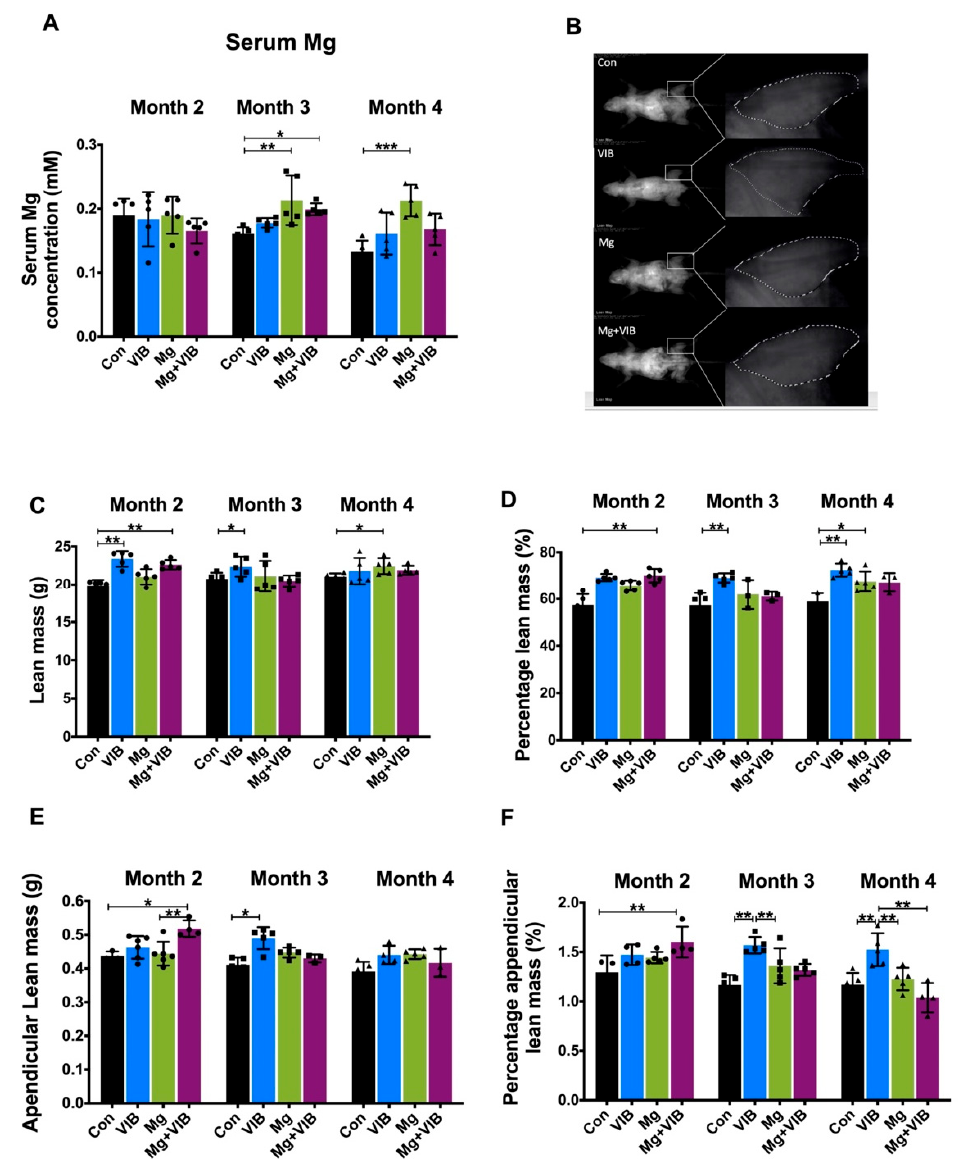
Figure 1. Body mass parameters by Dual Energy X-rat Absorptiometry (DXA) and serum Mg concentration of SAMP8 mice. ( A ) Serum Mg levels in Con group showed a decreasing trend from month 2 to month 4, and serum Mg concentration in the Mg group was significantly higher than in the Con group at month 4. ( B ) Representative DXA images in lean mass mode. ( C ) Lean mass, ( D ) lean mass percentage, ( E ) appendicular lean mass and ( F ) appendicular lean mass percentage of SAMP8 mice in different groups at month 2, 3 and 4 post treatment. Lean mass in the Mg group was significantly higher than in the Con group at month 4. Mg + VIB group showed a significantly higher lean mass/percentage and appendicular lean mass/percentage compared with the Con group at month 2, and the VIB group showed significantly higher mass/percentage and appendicular lean mass/percentage compared with the Con group at month 3 and significantly higher lean mass percentage and percentage lean mass at month 4. * p < 0.05, ** p < 0.01, *** p < 0.001, n = 3–5. VIB treatment alone showed enhancements on whole body muscle mass/percentage and appendicular muscle mass/percentage at month 3 post treatment (Figure 1B–F). Lean mass and appendicular lean mass in VIB group were 6.00% and 15.10% higher than in the Con group at month 3 (both at p < 0.05). The VIB group continued to present higher percentage lean mass and percentage appendicular lean mass at month 4 (both at p <